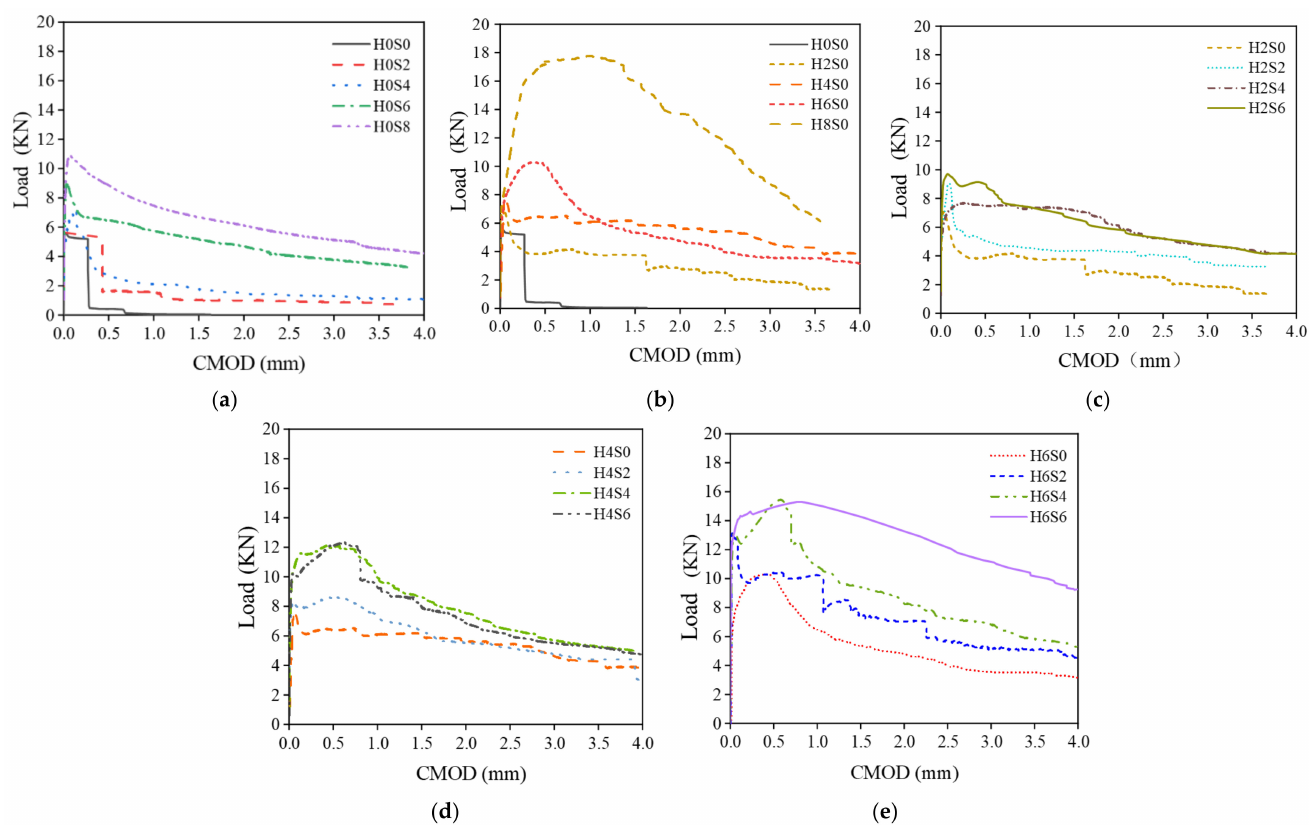
Figure 8. Load–CMOD experimental curve. ( a ) Straight fiber—single; ( b ) End-hooked fiber—single; ( c ) 0.2% end-hooked fiber—hybrid; ( d ) 0.4% end-hooked fiber—hybrid; ( e ) 0.6% end-hooked fiber—